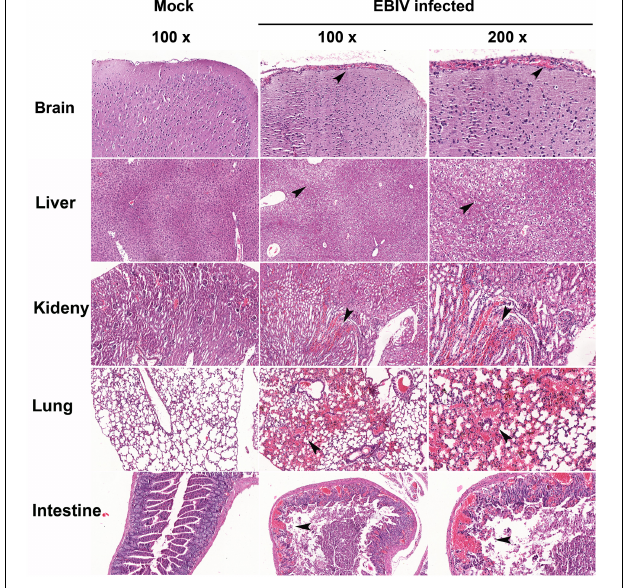
FIGURE 6 | Histopathological features in the organs of EBIV-infected mice. Prominent histopathological changes in the brain, liver, kidney, lung, and small intestine, and vasodilatation and congestion of the blood vessel around meninges have been found. Hematoxylin-and-eosin-stained sections are presented. Original magnification was 100 × in tissues of mock-infected, 100 × and 200 × in tissues infected with EBIV. The black arrows indicate histopathological changes.